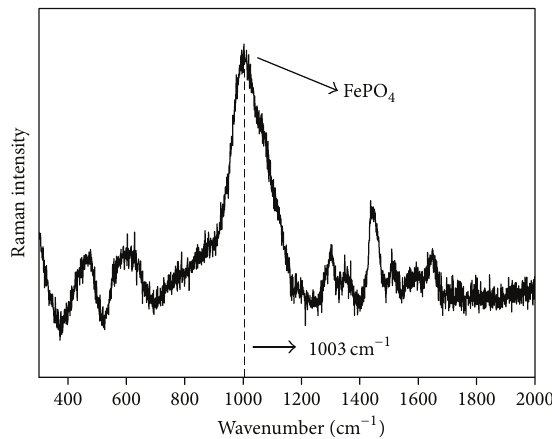
Figure 6: Raman spectra of FePO 4 collected as a function of power. The wavelength of the excitation laser is 633